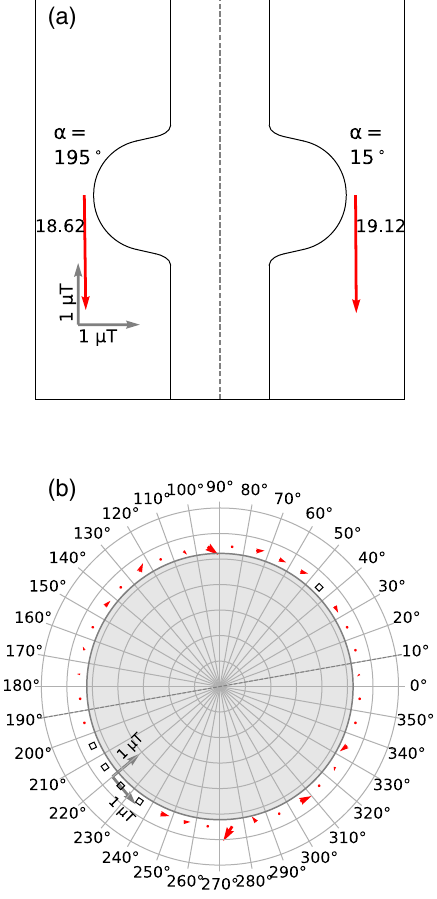
FIG. 9. The magnetic field change during flux exclusion with the applied magnetic field excited by a coil current of 10 mA ( Δ B ∼ − 1 . 8 μ T). (a) shows the z - θ projection and (b) shows the r - θ projection. In the plot (a), the numbers next to the arrows show the absolute value ( μ T) of magnetic field